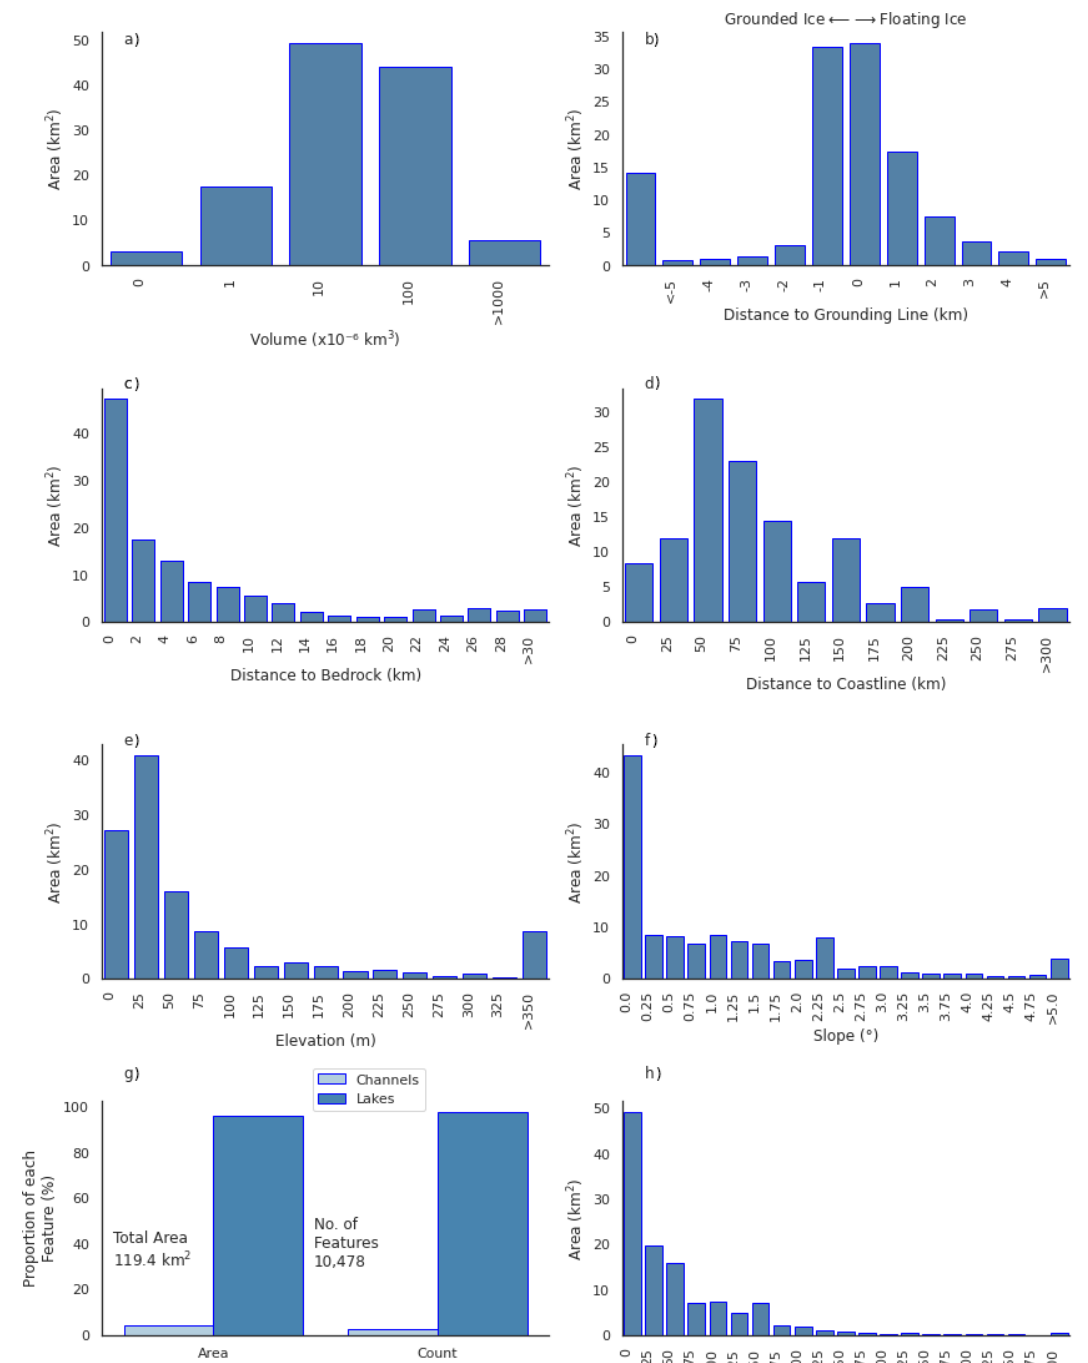
Figure 9. Area distributions of supraglacial lakes and channels on the WAIS and AP according to various glaciological variables. (a) In- dividual feature volumes from the area–volume scaling relationship (Eq. 8); (b) distance of each feature to the grounding line (negative values indicate lake and channel positions further inland from the grounding line); (c) distance of each feature to nearest exposed bedrock; (d) distance of each feature to the ice margin or coastline; (e) elevation at the centroid of each feature; (f) the surface slope at the centroid of each feature; (g) area and frequency split between channels and lakes on the WAIS and AP; (h) ice flow speed for each feature. Imagery was accessed from European Space Agency’s (ESA) Copernicus Scihub, http://scihub.copernicus.eu (last access: 3 December 2021), and US Geological Survey, http://earthexplorer.usgs.gov (last access: 3 December 2021).